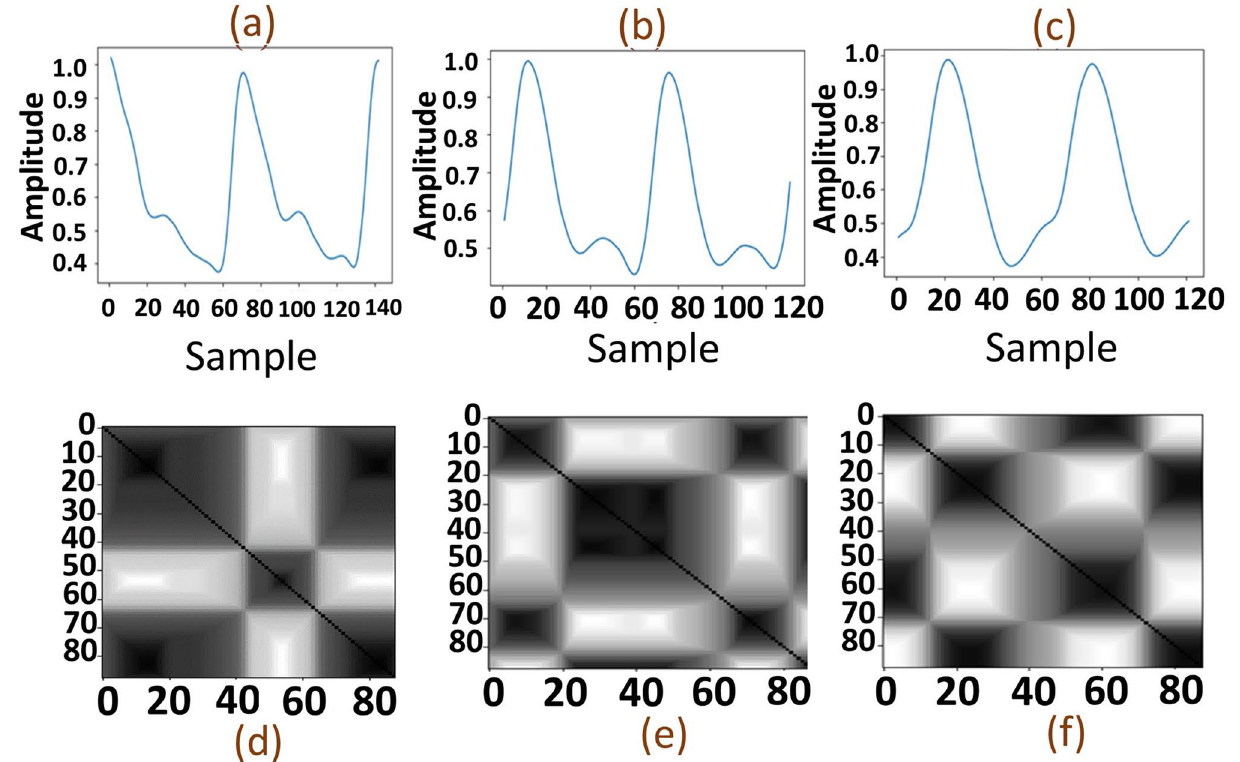
Figure 1. ( a – c ) are PPG signals and ( d – f ) are their respective FRPs with descending SBP and DBP at (162, 93) mmHg, (148, 74) mmHg, and (119, 52) mmHg, respectively. The recurrence properties of the PPG signals are depicted as a cluster texture features in the corresponding FRPs.